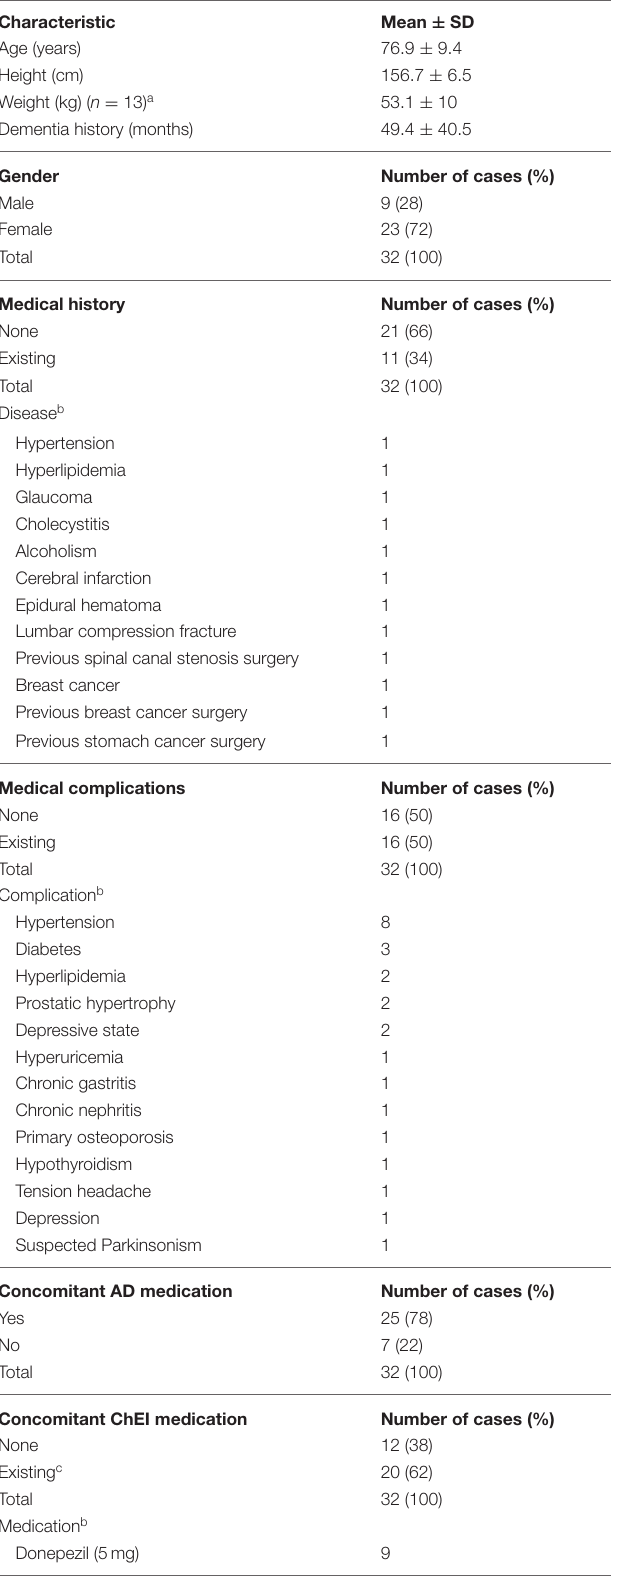
TABLE 1 | Sample characteristics.